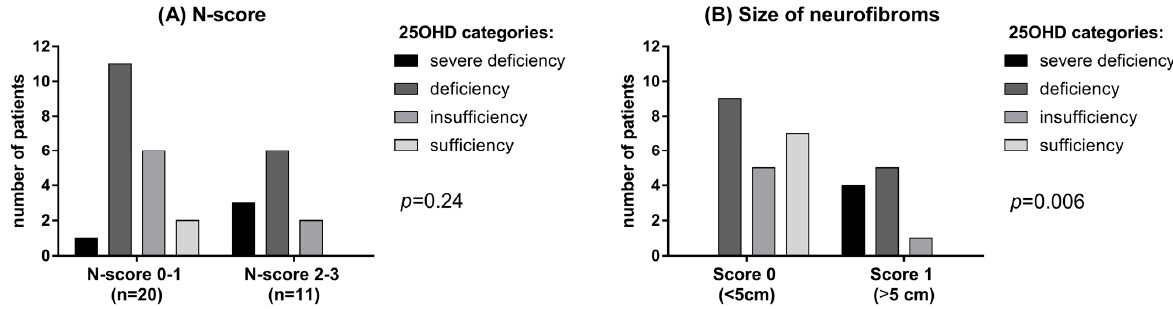
Figure 2. ( A ) 25OHD level in patients with different N-score. ( B ) 25OHD in patients with neurofibromas of different